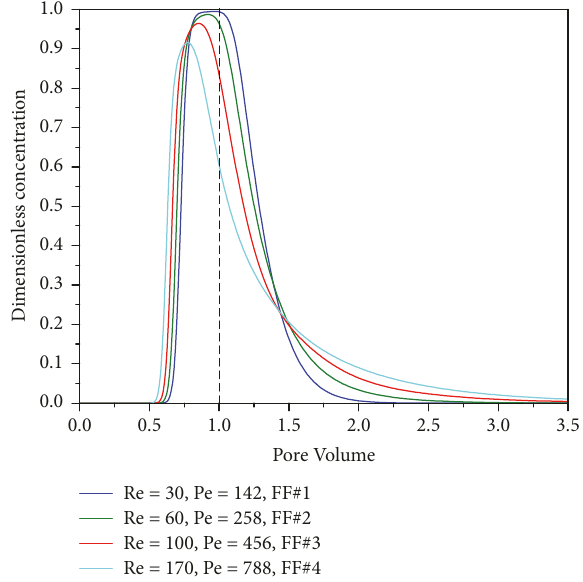
Figure 6: Breakthrough curves of reaction product C under the different flow fields in the single self-affine fracture with Hurst exponent of